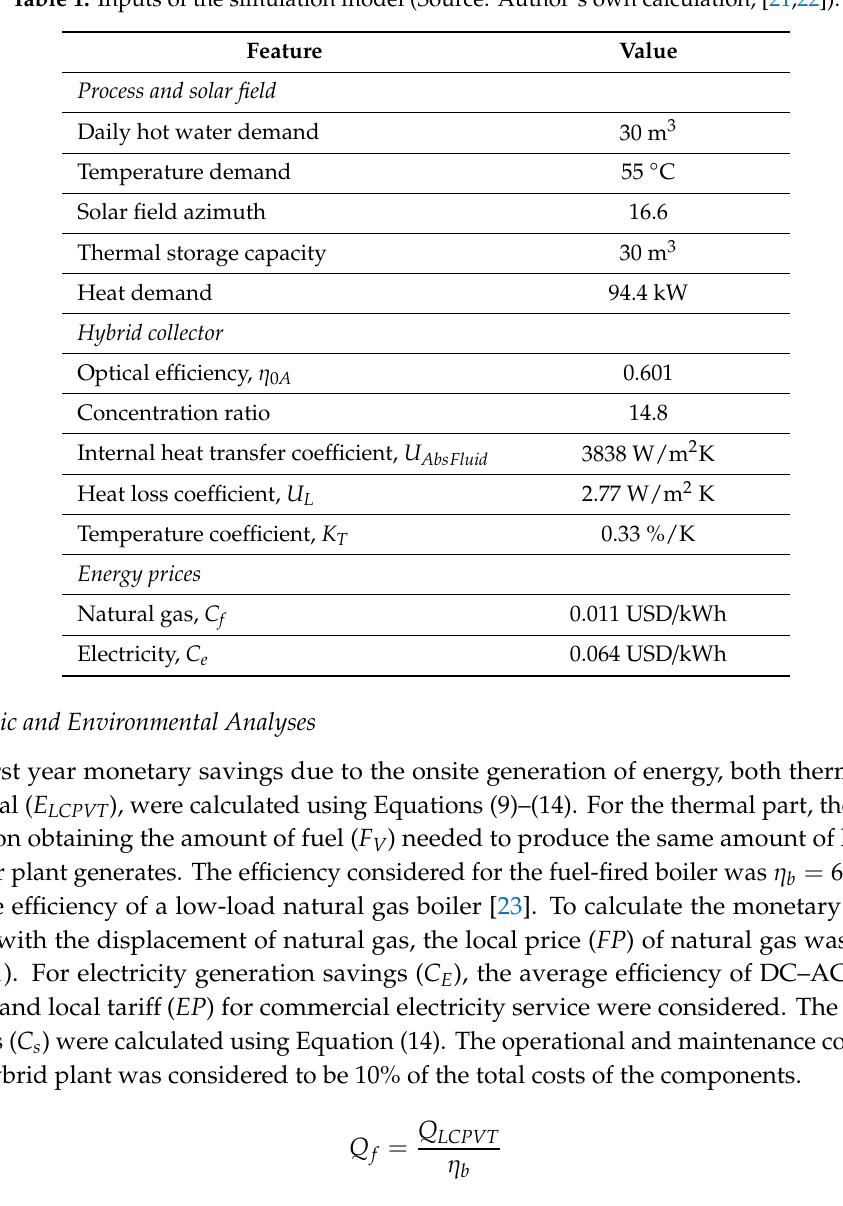
Table 1. Inputs of the simulation model (Source: Author’s own calculation,